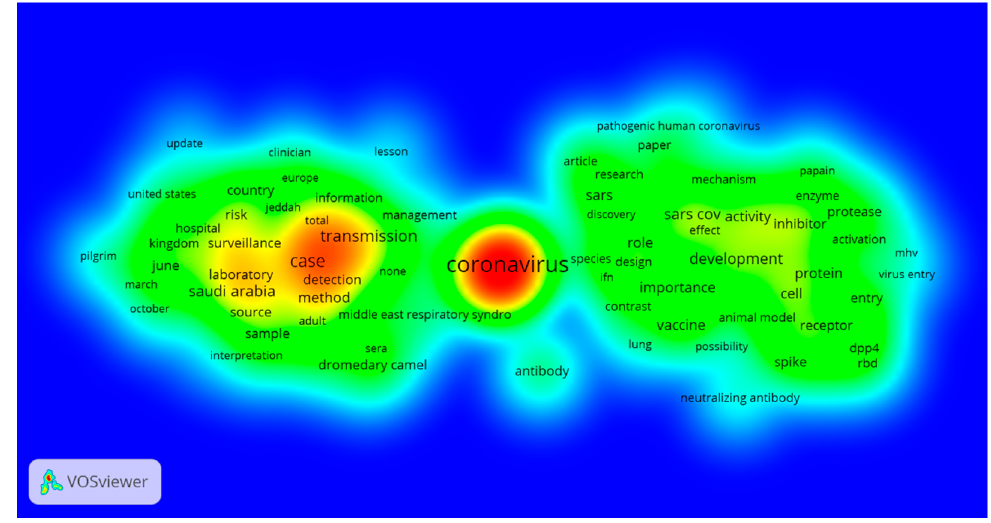
Figure 2. Map of frequent terms in MERS articles indexed in PubMed.